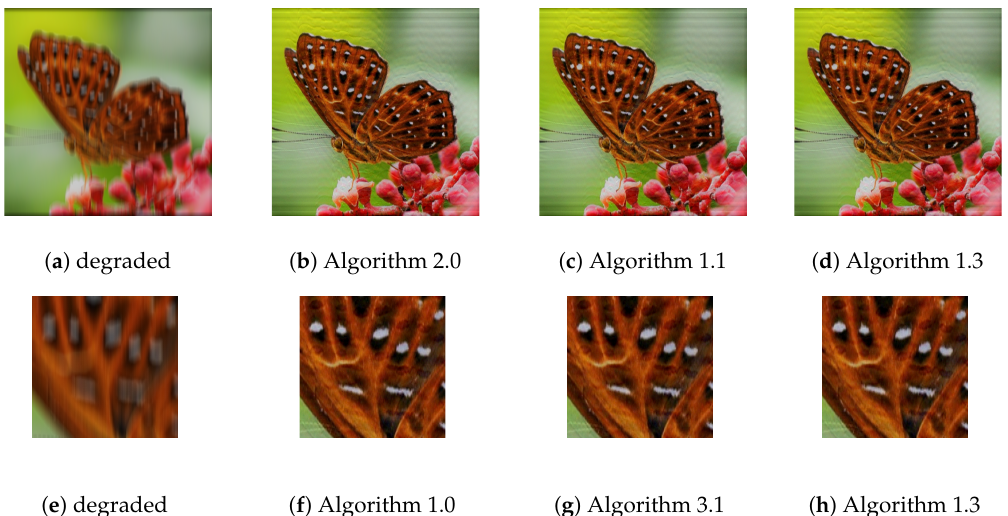
Figure 2. Degraded and restored ( a – d ) Butterfly images and ( e – h ) enlarged Butterfly images by the various